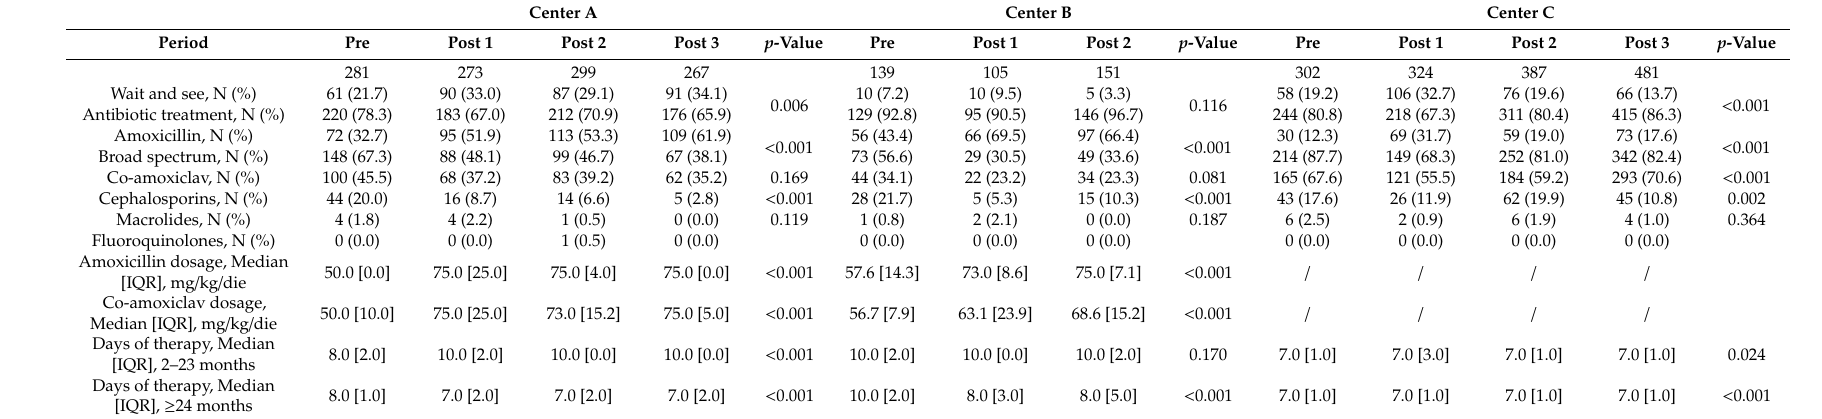
Table 2. Treatment option for acute otitis media in the di ff erent periods in the three